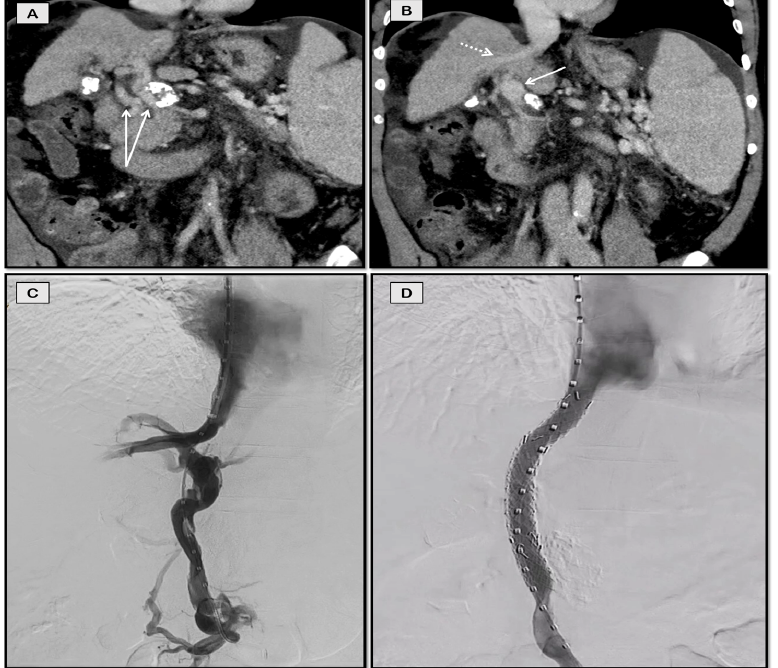
Figure 8. TIPS through collateral vein for refractory ascites in a 59-year-old man with chronic portal vein thrombosis secondary to NASH-cirrhosis. Coronal-oblique CT images ( A , B ) showing portal cavernoma (arrows in A ) and dominant collateral vein (solid arrow in B ) in the same plane as middle hepatic vein (dashed arrow in B ). Collateral vein was accessed through jugular route ( C ) and stented with restoration of flow ( D ).